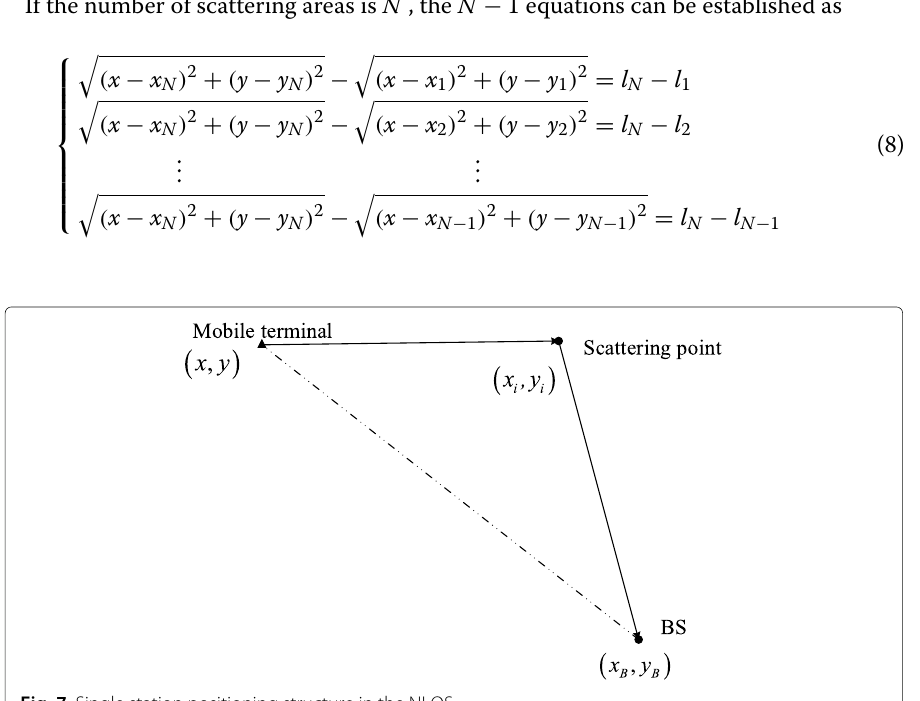
Fig. 7 Single station positioning structure in the